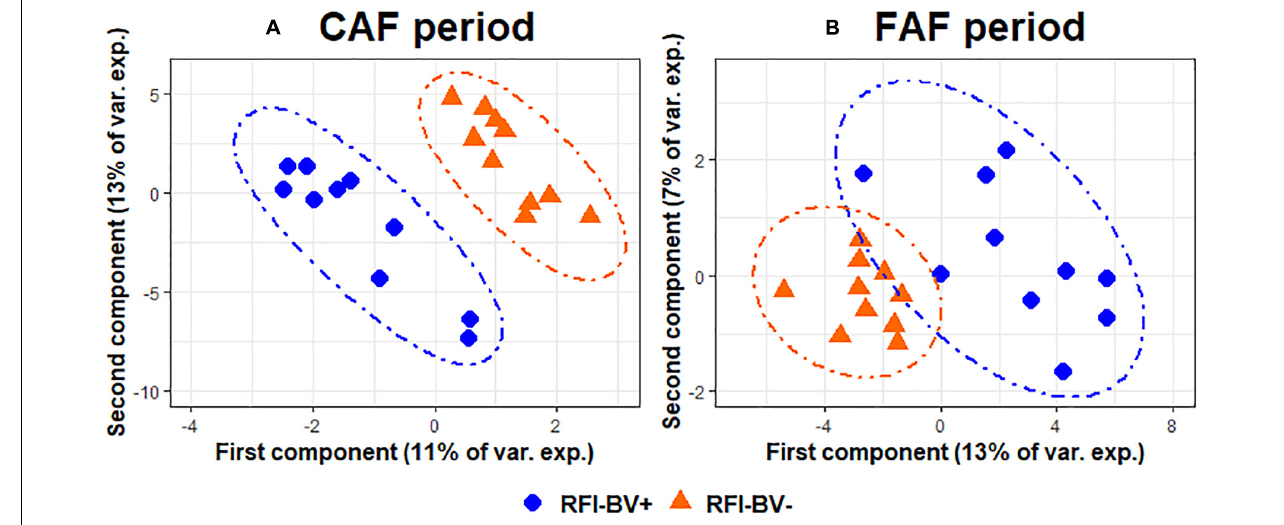
FIGURE 5 | Sparse partial least squares discriminant analysis of ruminal bacteria abundances at the genus level according to Residual Feed Intake index groups ( N = 20) during 100% concentrate CAF ( A - sPLS-DA with 3 components, 8, 50, and 90 variables per component and a BER of 0.20) and 67% forage FAF ( B - sPLS-DA with 3 components, 75, 1, and 1 variables per component and a BER of 0.10)